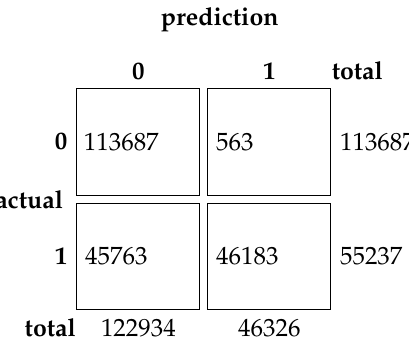
Figure 15. Confusion Matrix of